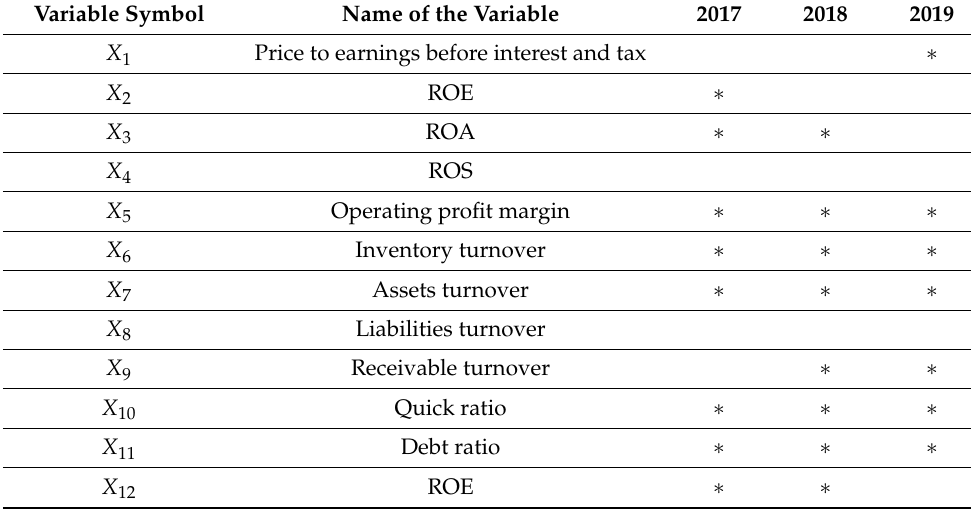
Table 4. Results of the reduction of variables by the inverse matrix method.